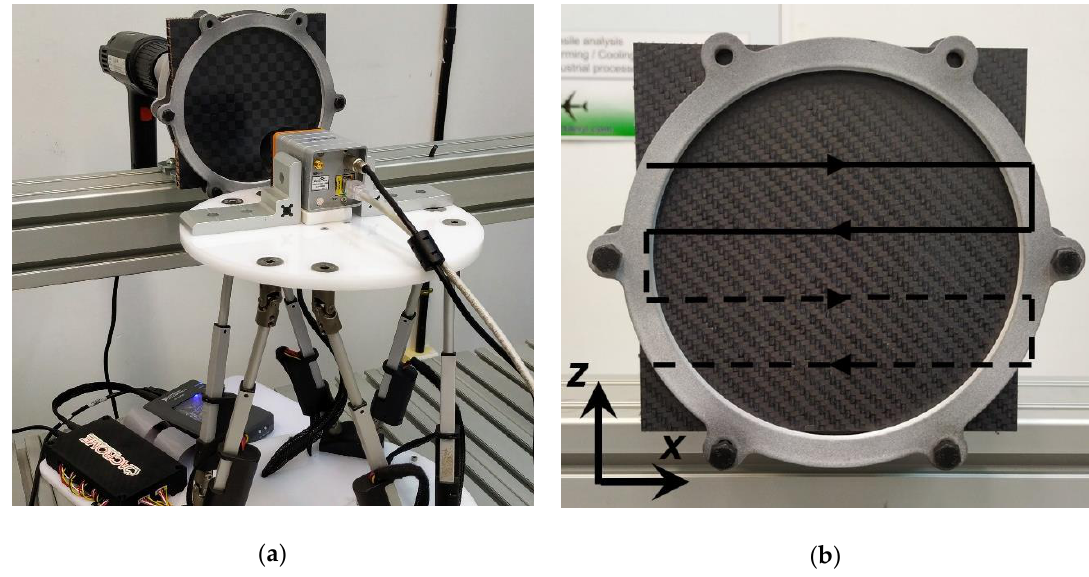
Figure 2. Inspection system prototype. ( a ) Test setup; ( b ) Trajectory scheme.